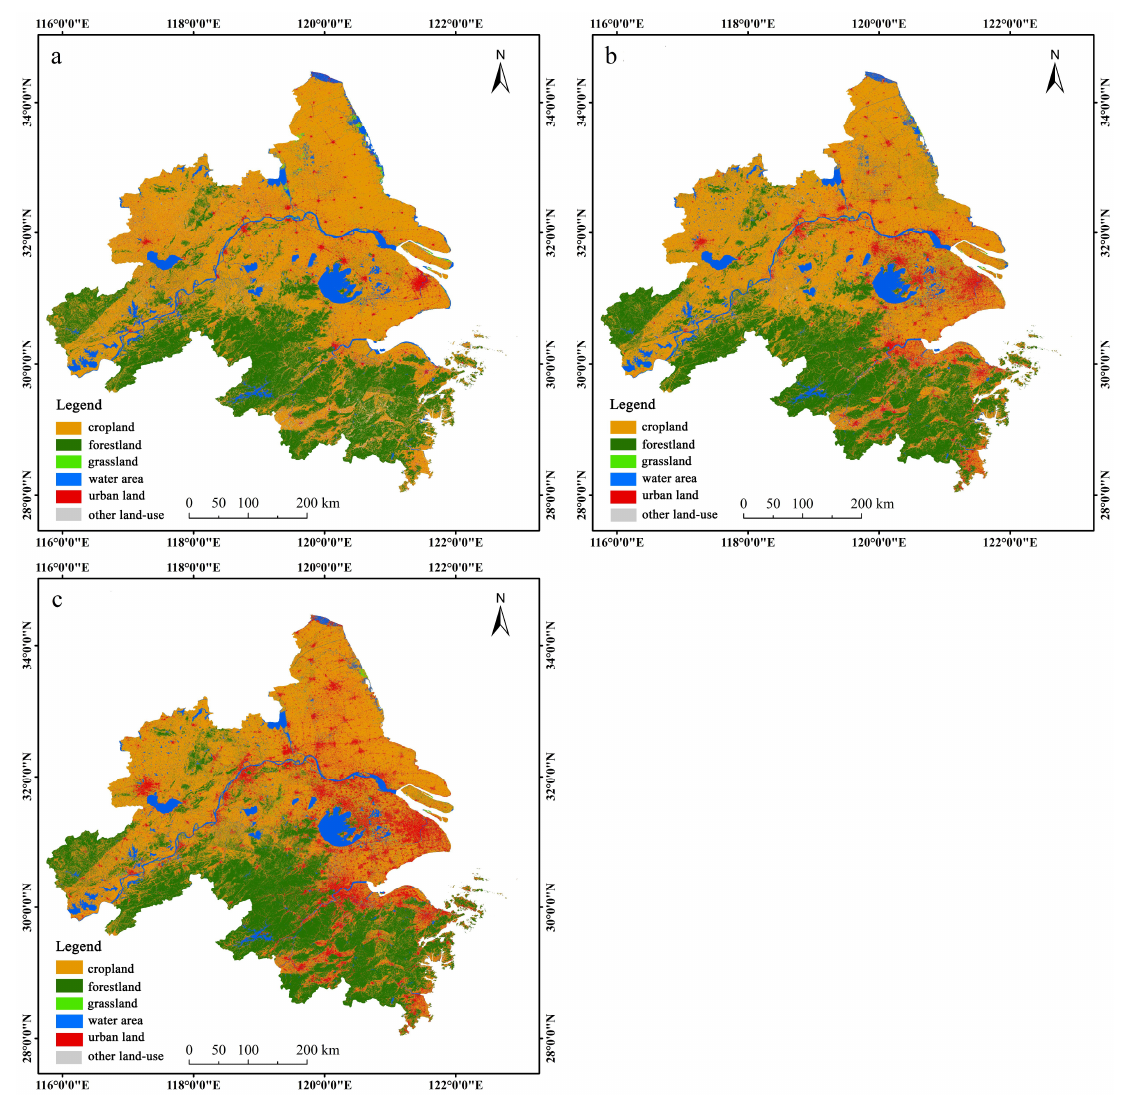
Figure 3. Land use classification maps of the YRDUA in 1995 ( a ), 2005 ( b ), and 2015 ( c